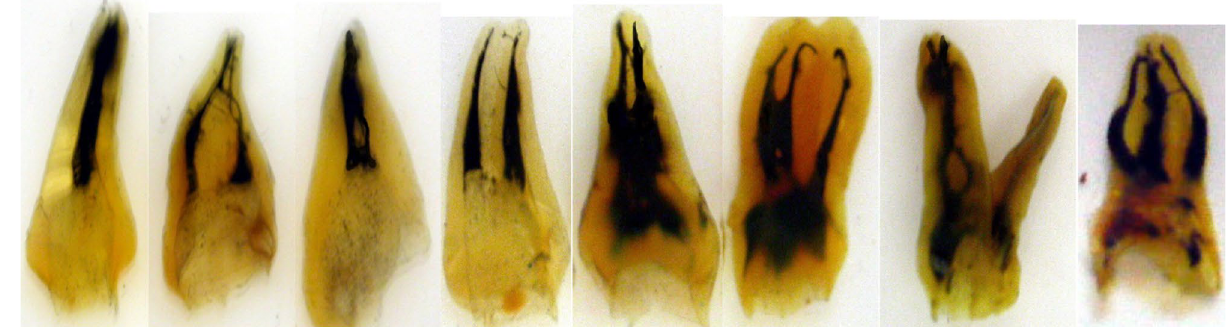
Figure 2. The eight types of Vertucci’s canal configuration in cleared maxillary third